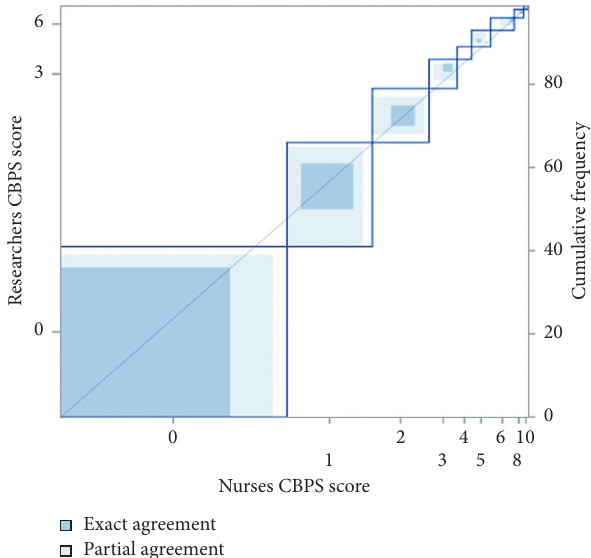
Figure 2: Interrater reliability for CBPS scores between nurses and researchers postprocedure.